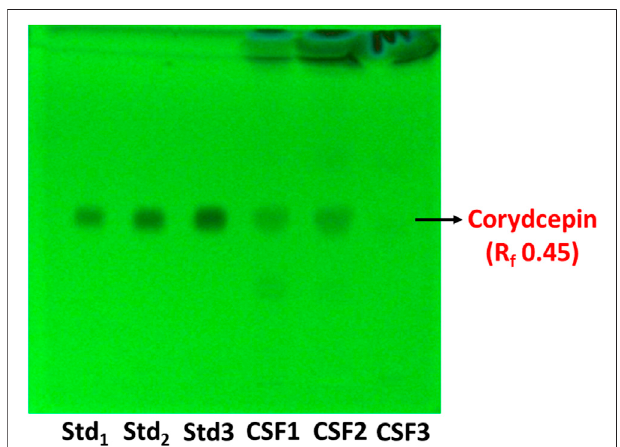
of cordycepin, the main marker metabolite used for quality assessment of Cordyceps spp. The retardation factor (R f ) was determined to be 0.45. Lanes labelled Std 1 , Std 2 and Std 3 contain 0.25, 0.5 and 1 µg of standard